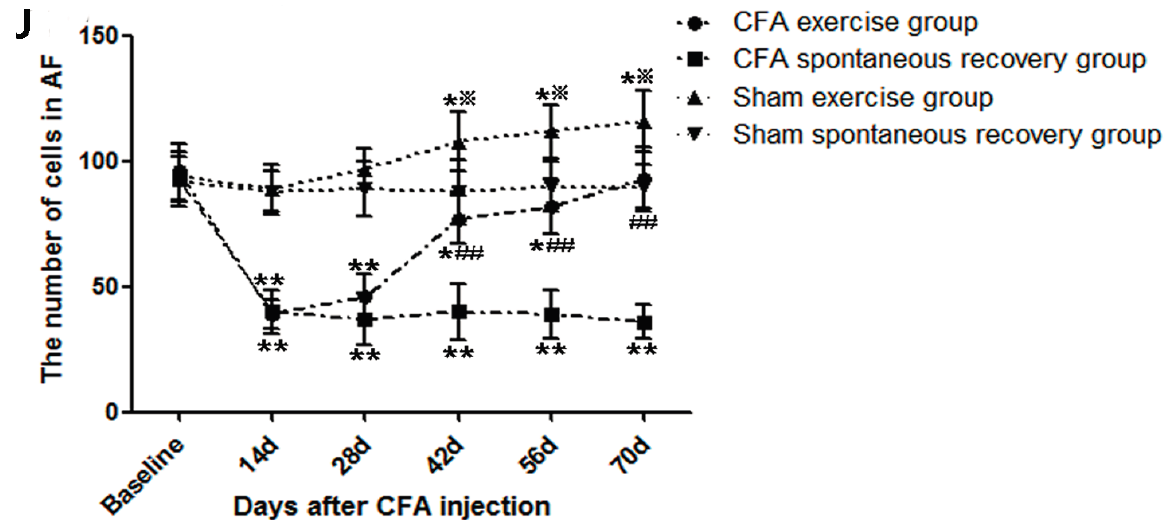
Figure 2. Photomicrographs of midsagittal sections of complete Freund’s adjuvant (CFA)-injected and sham-operation discs. ( A , B ) The discs of the CFA model rats exhibited dehydrated nucleus pulposus and blurred boundaries between the nucleus pulposus (NP) and anulus fibrosus (AF) areas at day 14 after CFA injection; ( C , D ) Intact NP and the clear distinction between NP and AF in discs of sham exercise groups at day 14 and day